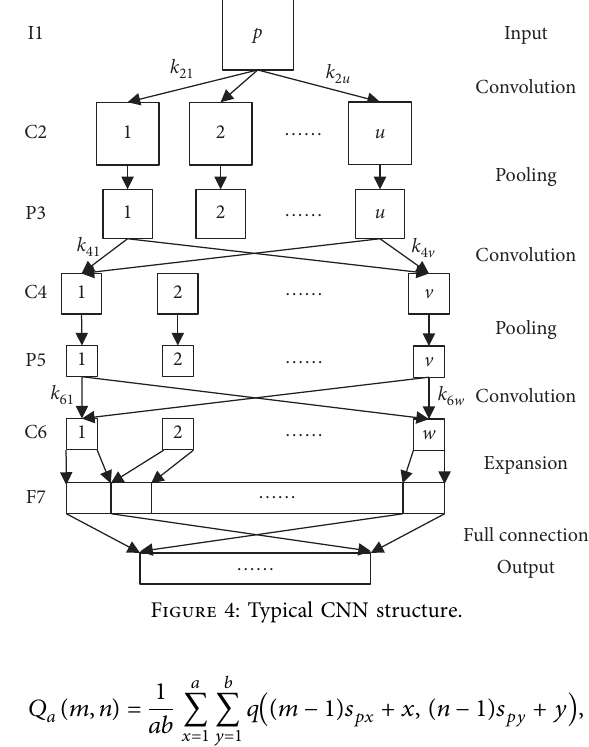
Figure 4: Typical CNN